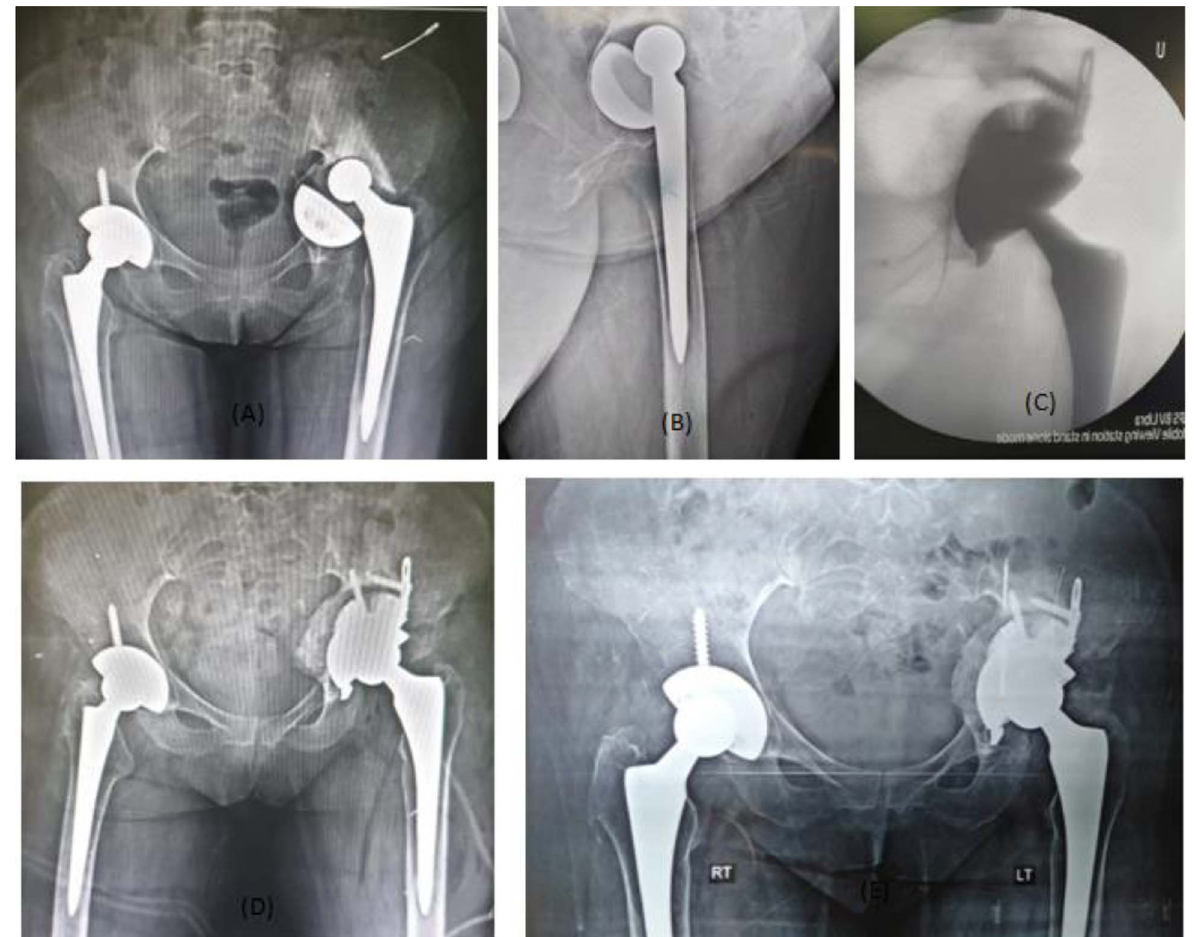
Figure 3. Male 50 years old with type IIIB defect treated with Lima TT revision shell and allograft. (A) Showing the preoperative X-ray AP view, (B) preoperative X-ray lateral view, (C) intraoperative image intensi fi er radiographs after cup application, (D) postoperative X-ray